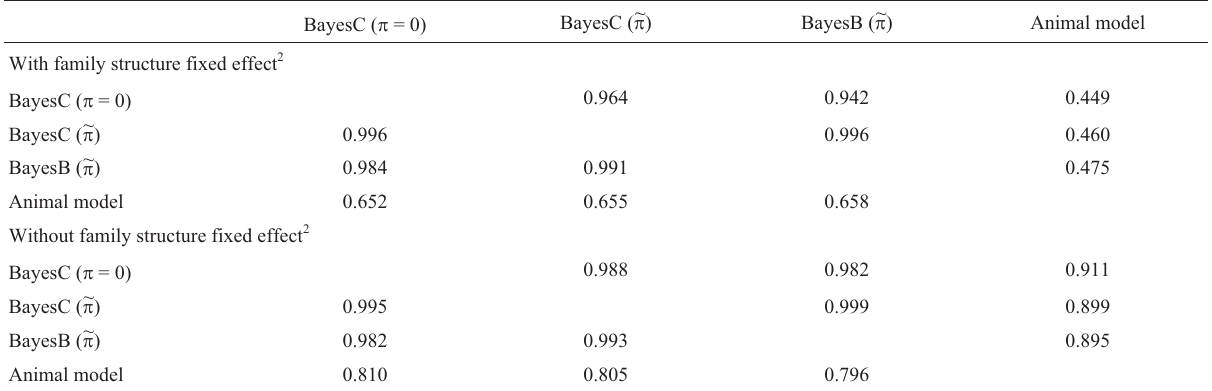
Table 4 - Spearman rank correlations (p < 0.001) of breeding values predicted from different analyses for overall temperament at weaning and Warner-Bratzler shear force 1 (~ (cid:2) BayesC ( (cid:2) = 0) BayesC